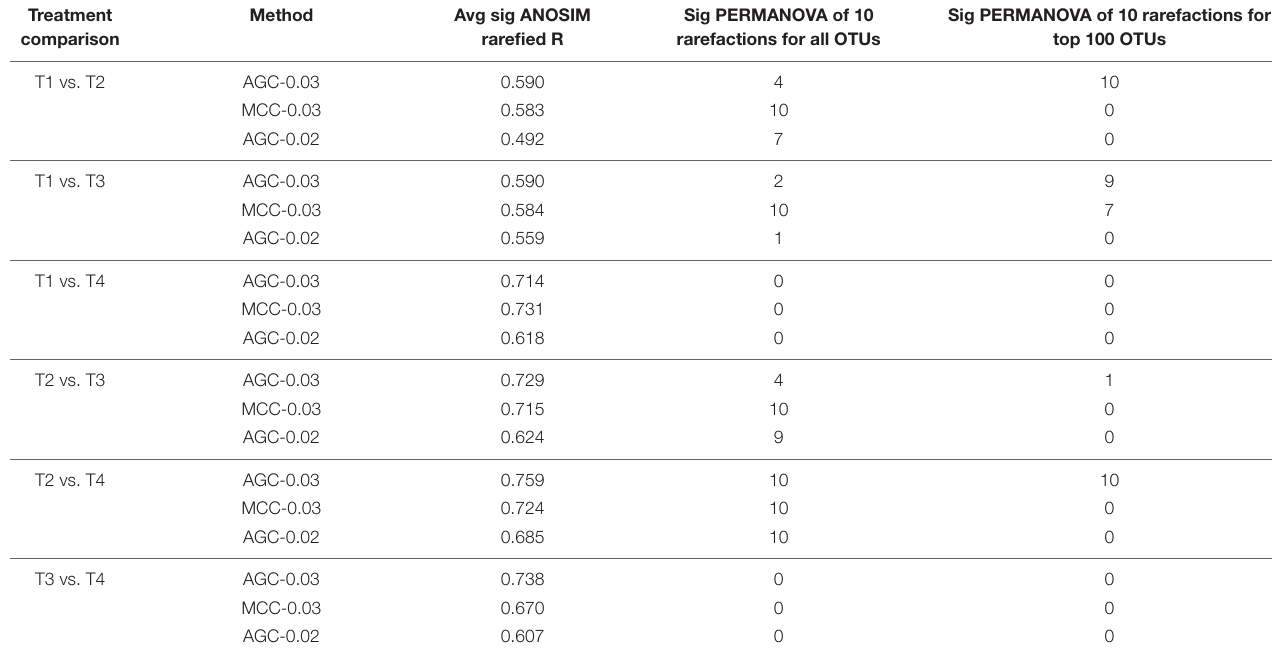
TABLE 6 | nrfA community analysis results for each clustering method across 10 independent rarefaction trials. Treatment